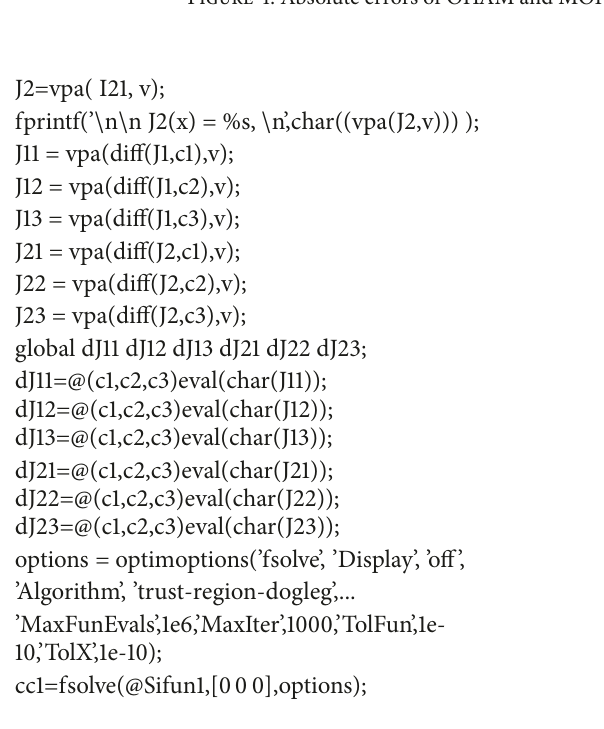
Figure 4: Absolute errors of OHAM and MOHAM for u2 in Example